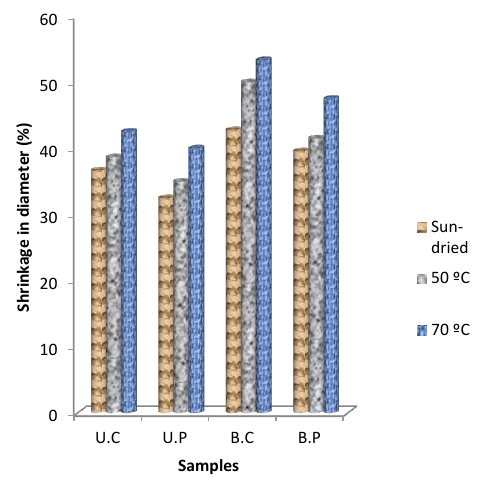
Figure 4: Shrinkage in diameter at different drying temperatures for cardaba banana and plantain slices U.C: Unblanched cardaba banana U.P: Unblanched plantain B.C: Blanched cardaba banana B.P: Blanched plantain